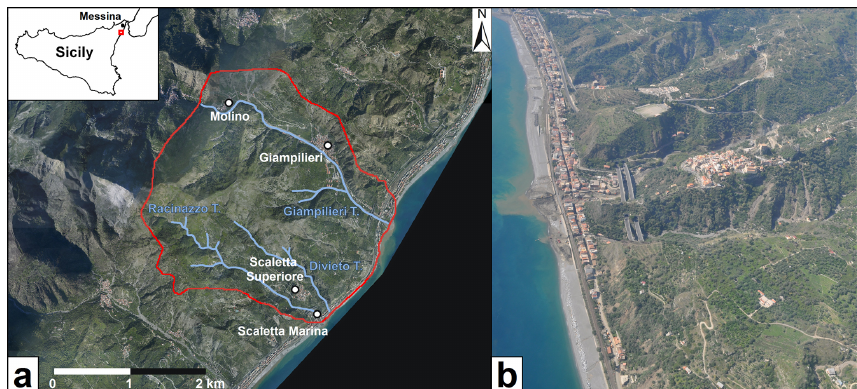
Figure 1. (a) Extent of the study area (red line). The upper left sketch shows the location of the area, represented by the red square; (b) aerial view of the Giampilieri area a few days after the 1 October 2009 event.